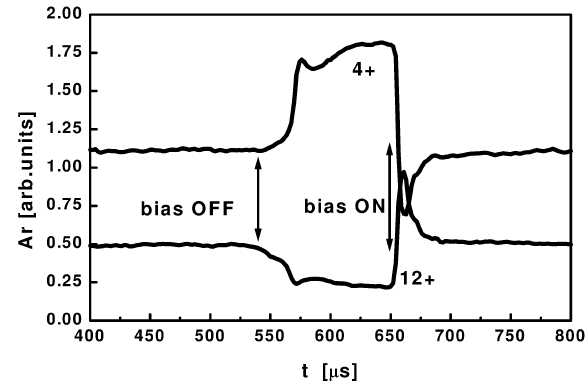
FIG. 6. Time structure of Ar 4 1 and Ar 12 1 ion currents from an Ar (cid:1) O 2 (gas mixing) plasma. The amplitude of the biased- disk voltage pulse was 2 200